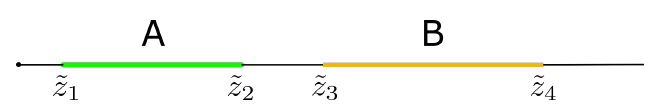
Figure 19. Configuration involving two disjoint intervals away from the boundary in a BCFT 1+1 . A away from the